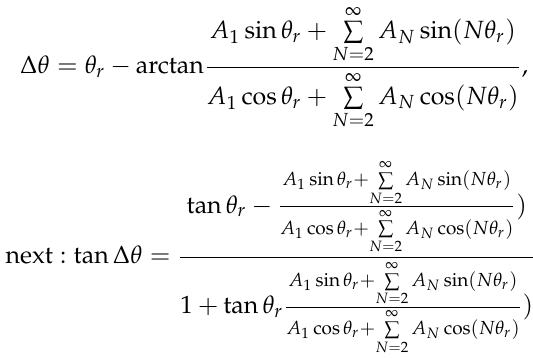
θ . Figure 3. Distribution law of ∆ θ P in one period of θ r r